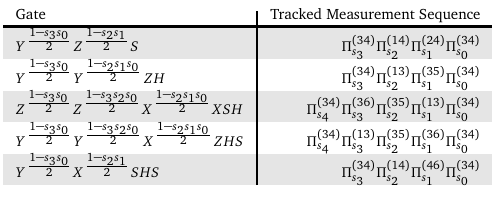
Table 7: Pauli gate corrections tracked for the corresponding single-qubit gates implemented using Majorana-Pauli tracking methods. The implicit action on the 1 − sns 0 Π ( 34 ) ancillary qubit is X for sequences of length n . 2 s 0